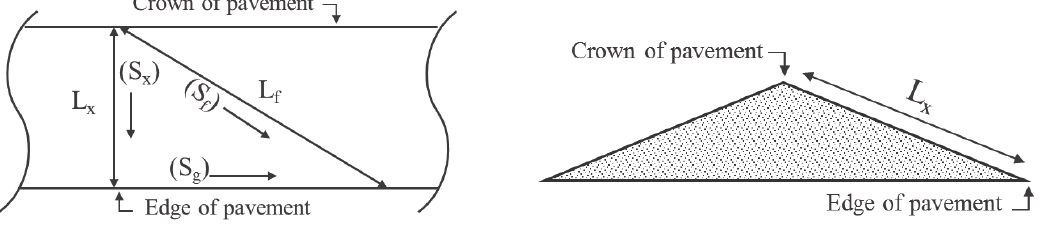
Figure 1. Defi nition scheme of runway transverse/longitudinal slopes (Guven & Melville,